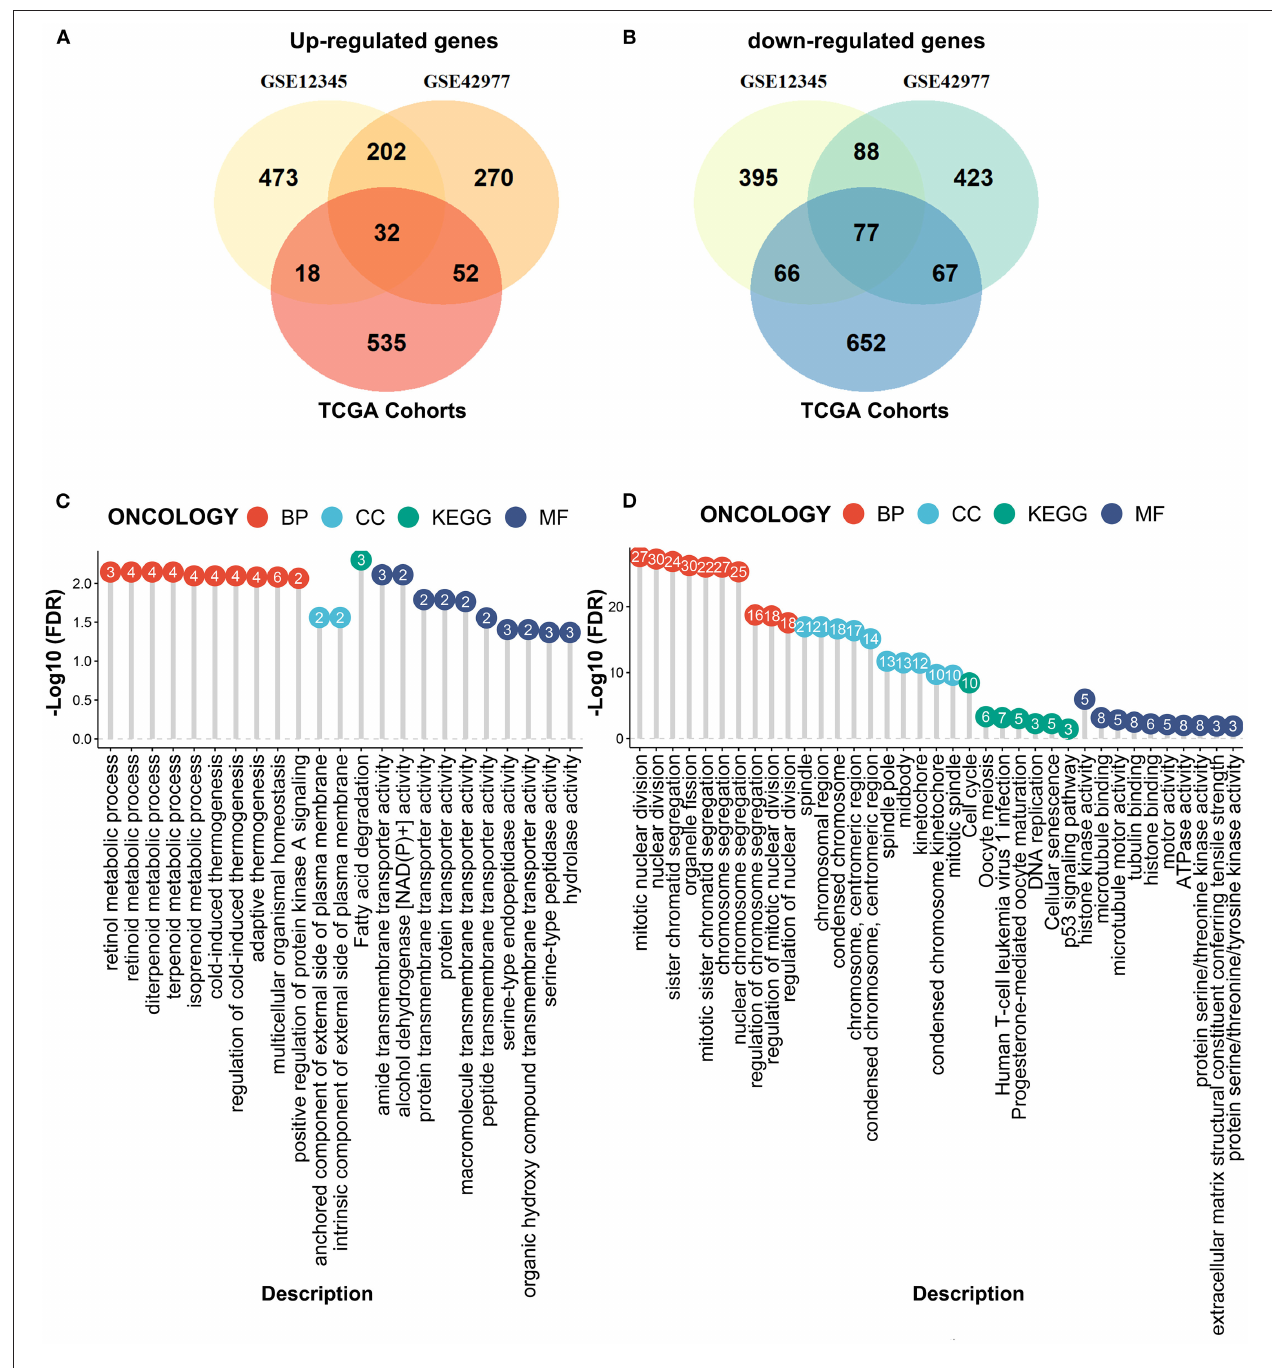
FIGURE 3 | Compared the DEmRNAs obtained from the RNA-seq data and the microarray data. (A) The overlapped upregulated genes. (B) The overlapped downregulated genes. (C) The enrichment analyses of the overlapped upregulated genes. (D) The enrichment analyses of the overlapped downregulated genes.